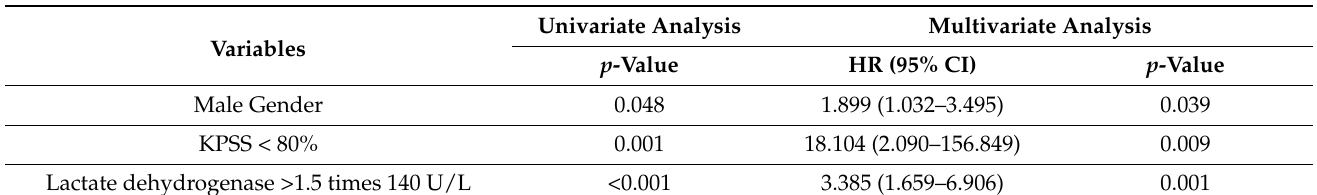
Table 3. Univariate and multivariate analyses for negative prognostic factors for DFI between primary renal cancer and first pulmonary